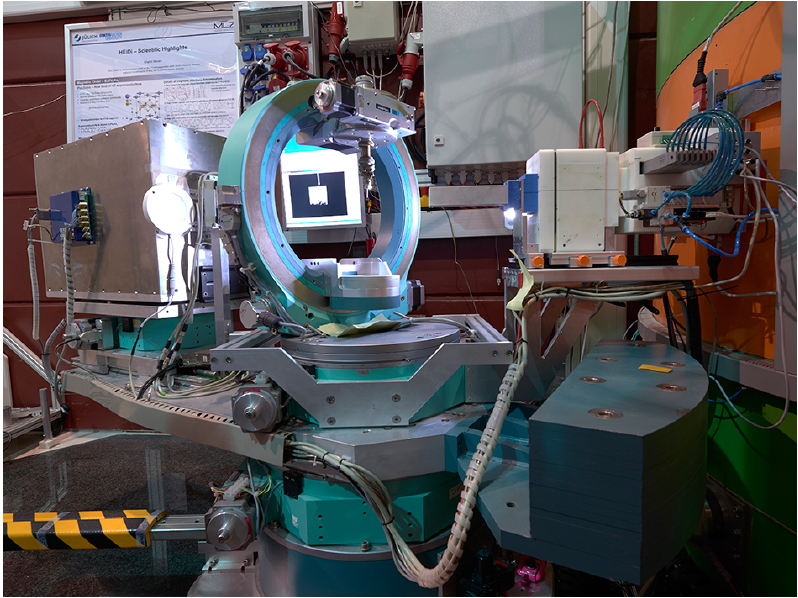
Figure 1: Instrument HEiDi (Copyright by W. Schürmann,